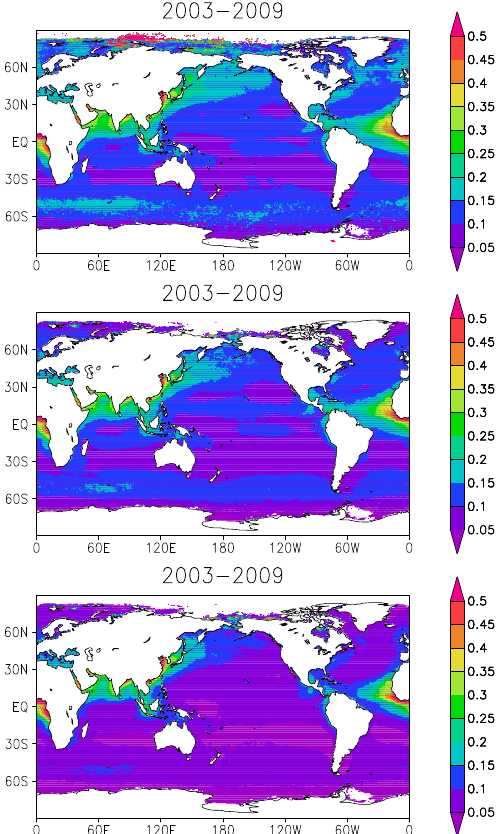
Fig. 16. Multi-year averages (2003–2009) of MODIS Aqua AE. The top panel shows the original MODIS Coll. 5 level 2 product. The middle panel shows the screened product and the bottom panel shows the corrected